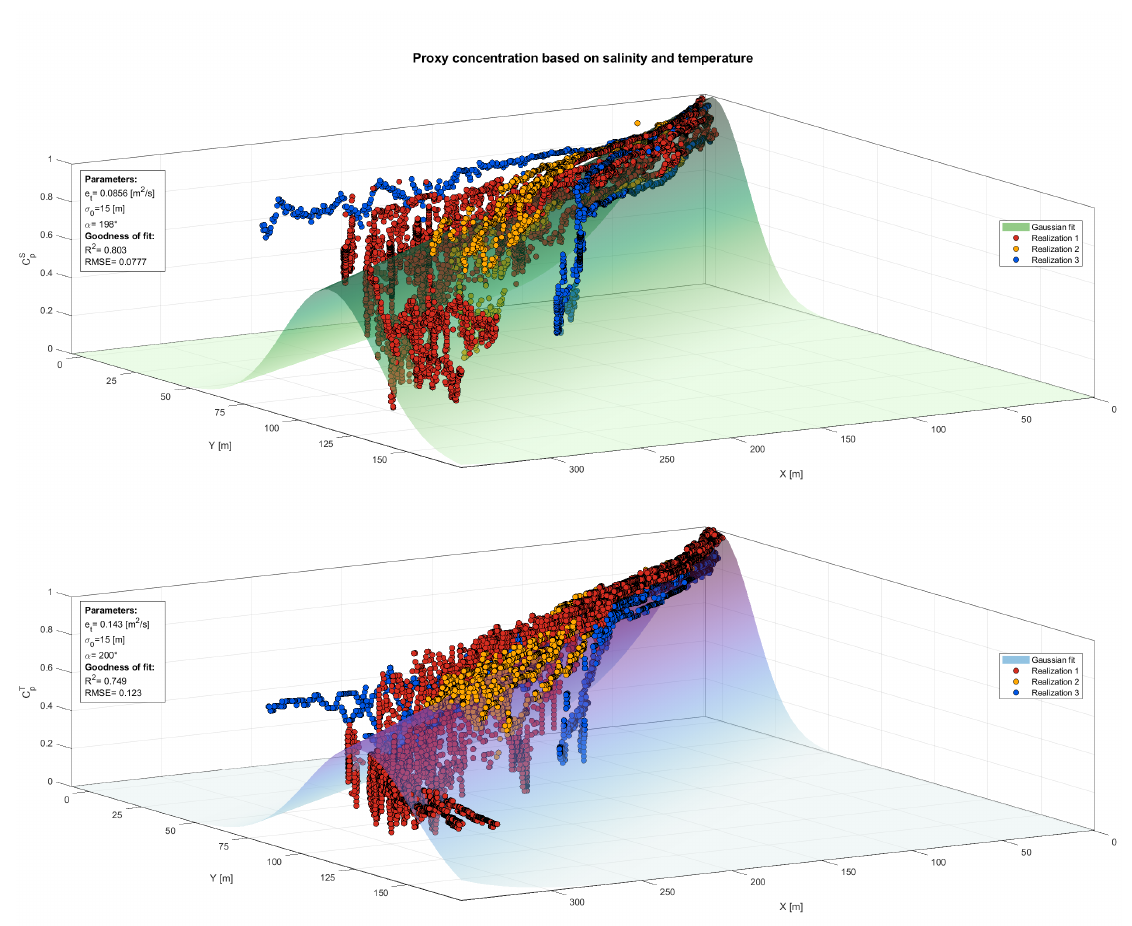
Figure 20. Comparison between the measured data and Gaussian mean distribution for: salinity as a concentration proxy ( top ); and temperature as a concentration proxy ( bottom